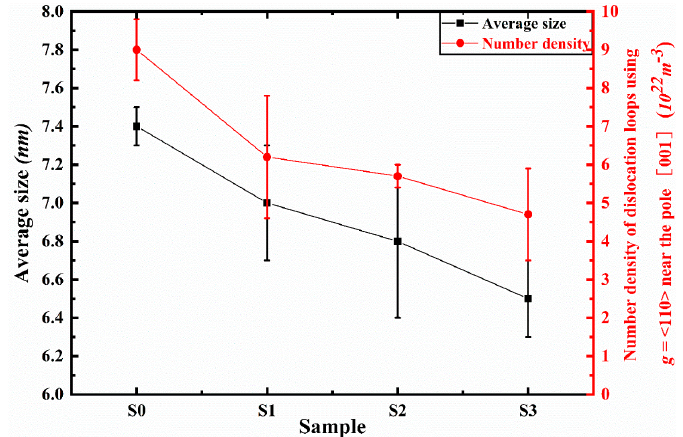
Figure 5. Size and number density of dislocation loops using g = <110> near the pole [001] (10 22 m − 3 ).